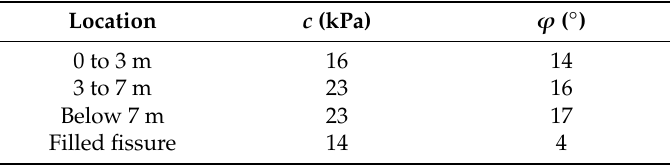
Table 4. Calculation parameters of expansive soils in the slope.